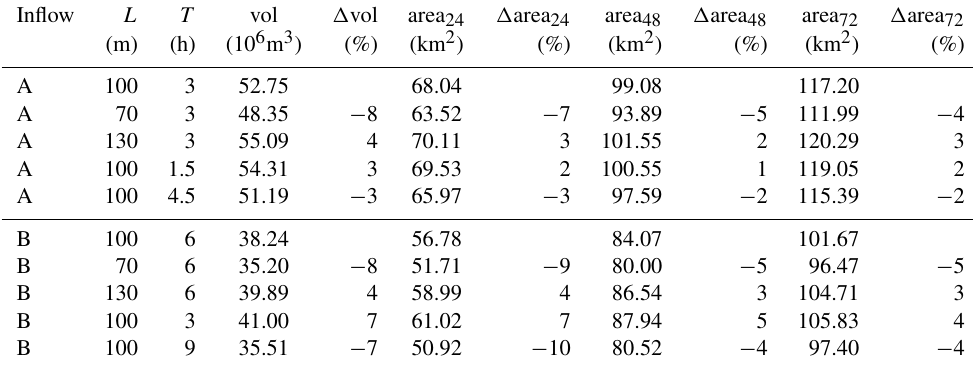
Table 1. Sensitivity analysis on the final breach width L and opening time T for one scenario on the Secchia River (see Fig. 3), with both inflows A and B. Results are compared based on the total outflow volume (vol) and the flooded area 24, 48 and 72h after the breach opening (area 24 , area 48 and area 72 , respectively). Their relative differences ( (cid:49) vol, (cid:49) area 24 , (cid:49) area 48 and (cid:49) area 72 ) with reference to the baseline simulation are also reported for each tested